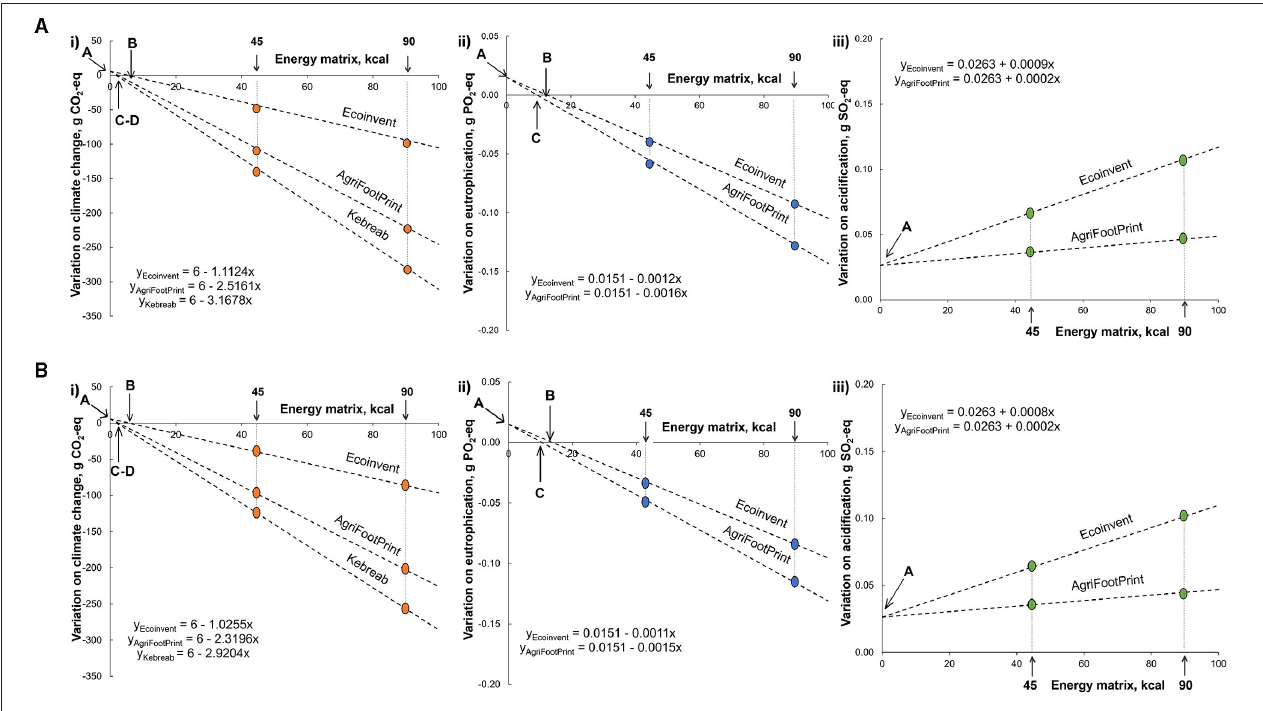
FIGURE 6 | Minimum energy matrix necessary to mitigate the environmental cost associated with β -mannanase supplementation in pig (A) and broiler (B) feeds. Within each panel, the letter A indicates the environmental cost of β -mannanase supplementation for 1kg of feed, while letters B (Ecoinvent database v. 3.0, Swiss Center for Life Cycle Inventories, Dübendorf, Switzerland), C (AgriFootPrint v. 5.0, Blonk Consultants, Gouda, The Netherlands), and D [Kebreab et al. (24)] indicate the energy matrix able to mitigate this impact on climate change (i), eutrophication (ii), and acidification (iii) depending on the reference considered to account soybean oil